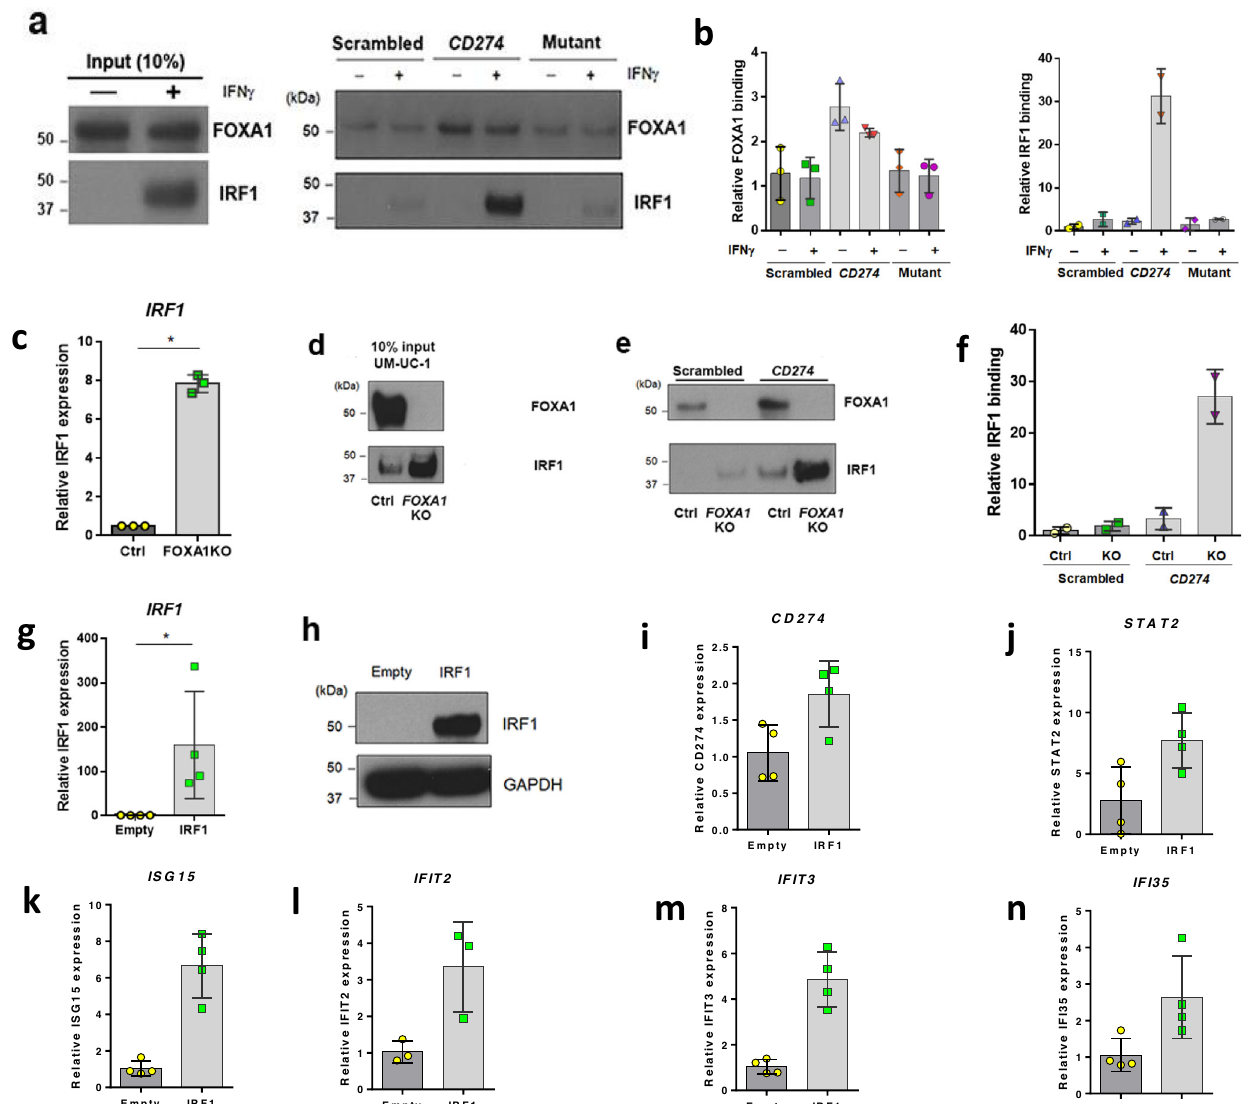
Fig.7|FOXA1KOincreasesexpressionofIRF1andenhancesIRF1bindingtothe CD274 promoter. Western blotting ( a ) and quanti fi cation ( b ) following DNA af fi - nitypuri fi cationforFOXA1(n=3)andIRF1( n =2)inparentalUM-UC-1treatedinthe presence and absence of IFN ɣ . In the absence of IFN ɣ , FOXA1 exhibits signi fi cantly greater binding to the wild-type CD274 probe relative to scrambled negative con- trolDNAprobe(Student ’ s t- test; p =0.0319)ormutant(Student ’ s t- test; p =0.0256) CD274 probes. In the presence of IFN ɣ , FOXA1 still showed signi fi cantly greater bindingtowild-type CD274 promoterrelativetoscrambledDNAprobe(Student ’ s t - test; p =0.0319) and FOXA1-binding mutant (Student ’ s t -test; p =0.0256) CD274 probes. There were no signi fi cant differences in FOXA1 binding relative to IFN ɣ treatment. Following IFN ɣ treatment, IRF1 shows increases in binding to wild-type CD274 relative to scrambled and mutant probes. Q-RT-PCR data are expressed as the mean±S.D. from independent experiments of FOXA1 ( n =3), IRF1 ( n =2), respectively.SourcedataareprovidedasaSourceData fi le( c )andwesternblotting ( d ) shows that FOXA1 KO in UM-UC-1 results in signi fi cant increases in IRF1 expression at the mRNA and protein levels, respectively. Data of Q-RT-PCR are